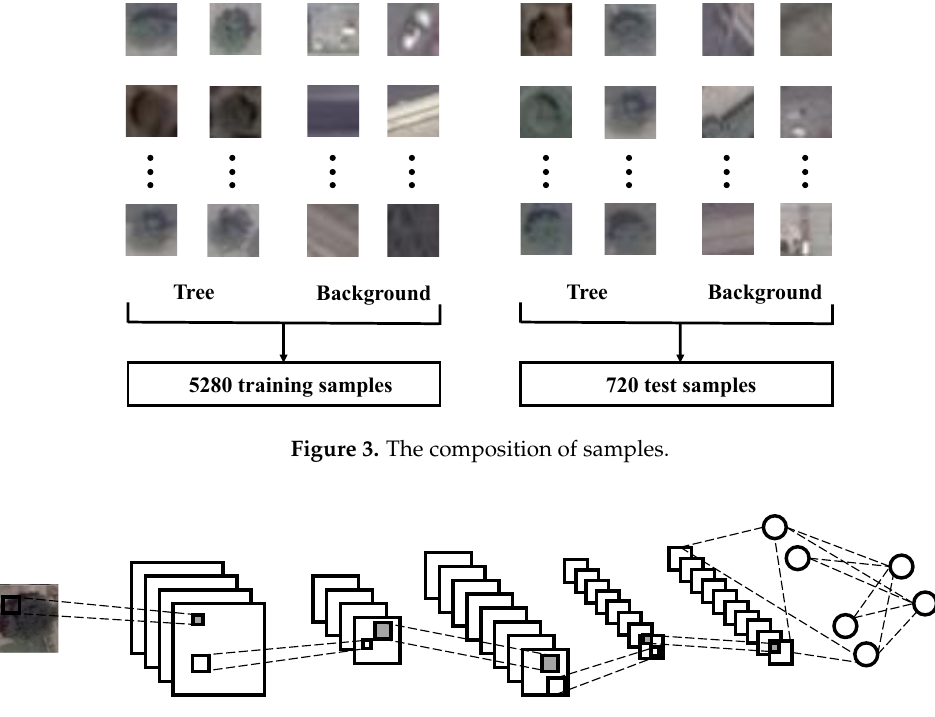
Figure 4. The diagram of classification